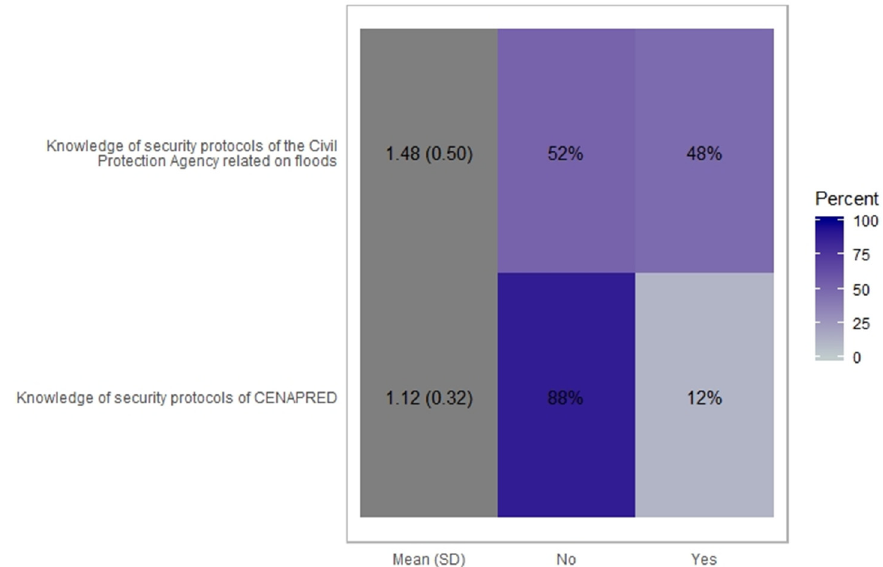
Figure 4. Graphic generated by percentage of perceived knowledge of security protocols of the Civil Protection Agency related on floods.